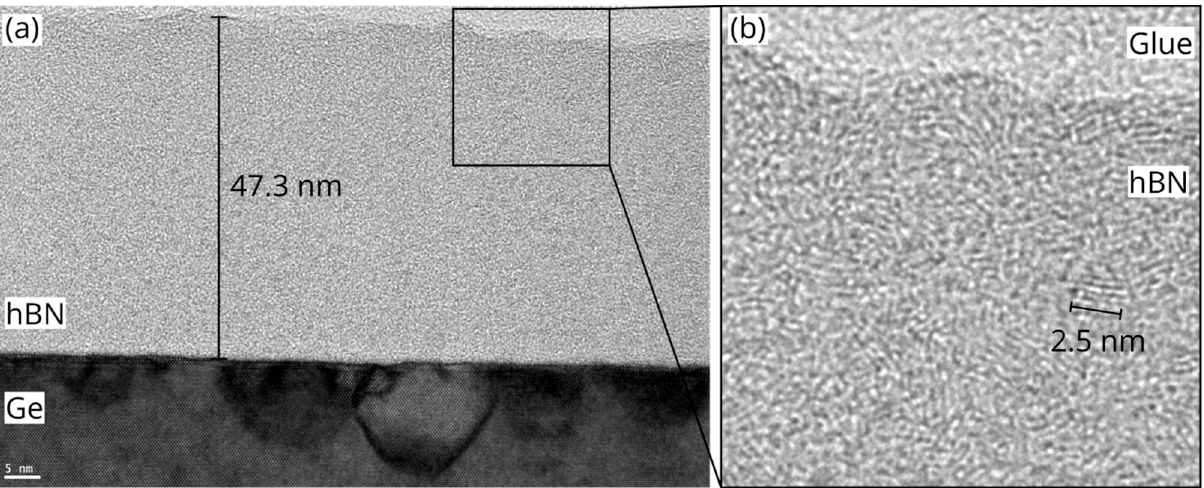
Figure 4. ( a ) Cross-section TEM image of hBN film grown on Ge(001) at 900 °C and 1 × 10 − 3 mbar. The scale bar is 5 nm. ( b ) Zoomed in view of the area indicated in ( a ) by the black square.